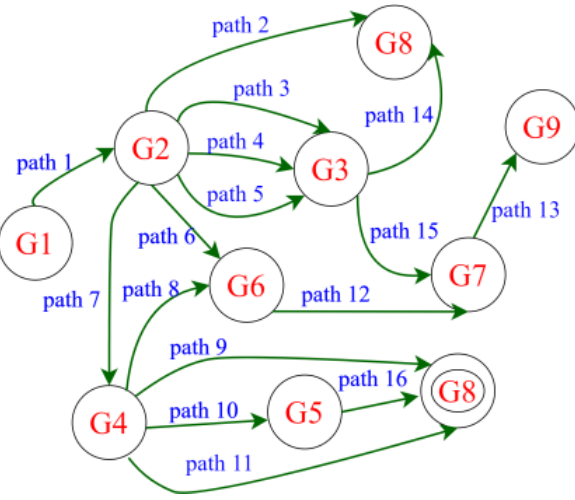
Figure 2. Illustration of graph representation considering MCM.